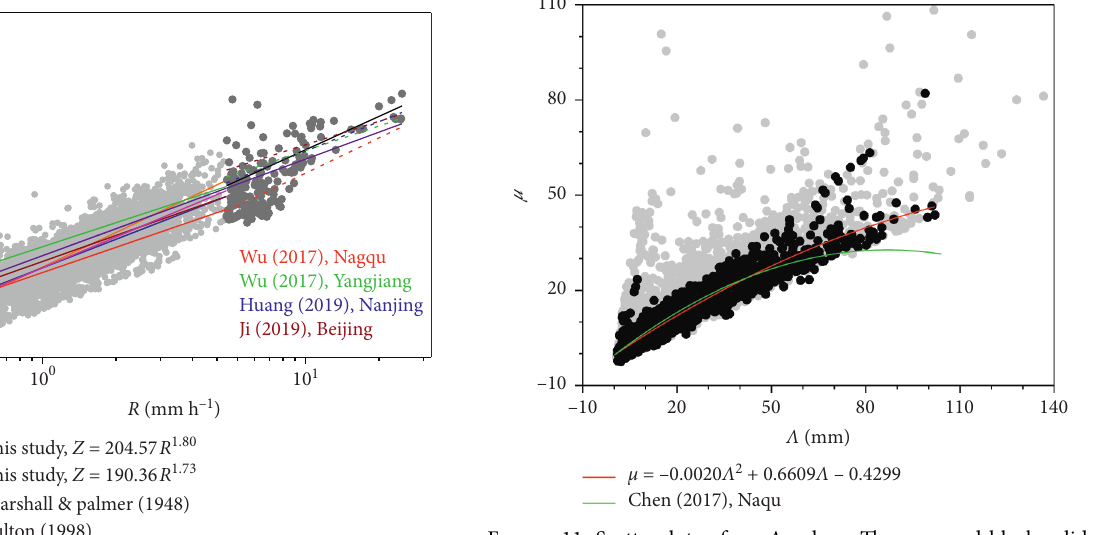
Figure 11: Scatterplots of μ − Λ values. The gray and black solid circles are points from all the data and the filtered data with drop counts > 300, respectively. The red line and the equation shown in the figure represent a least-squares fit to the filtered data. The green line represents the μ − Λ relation in previous studies by Chen et al. [7].